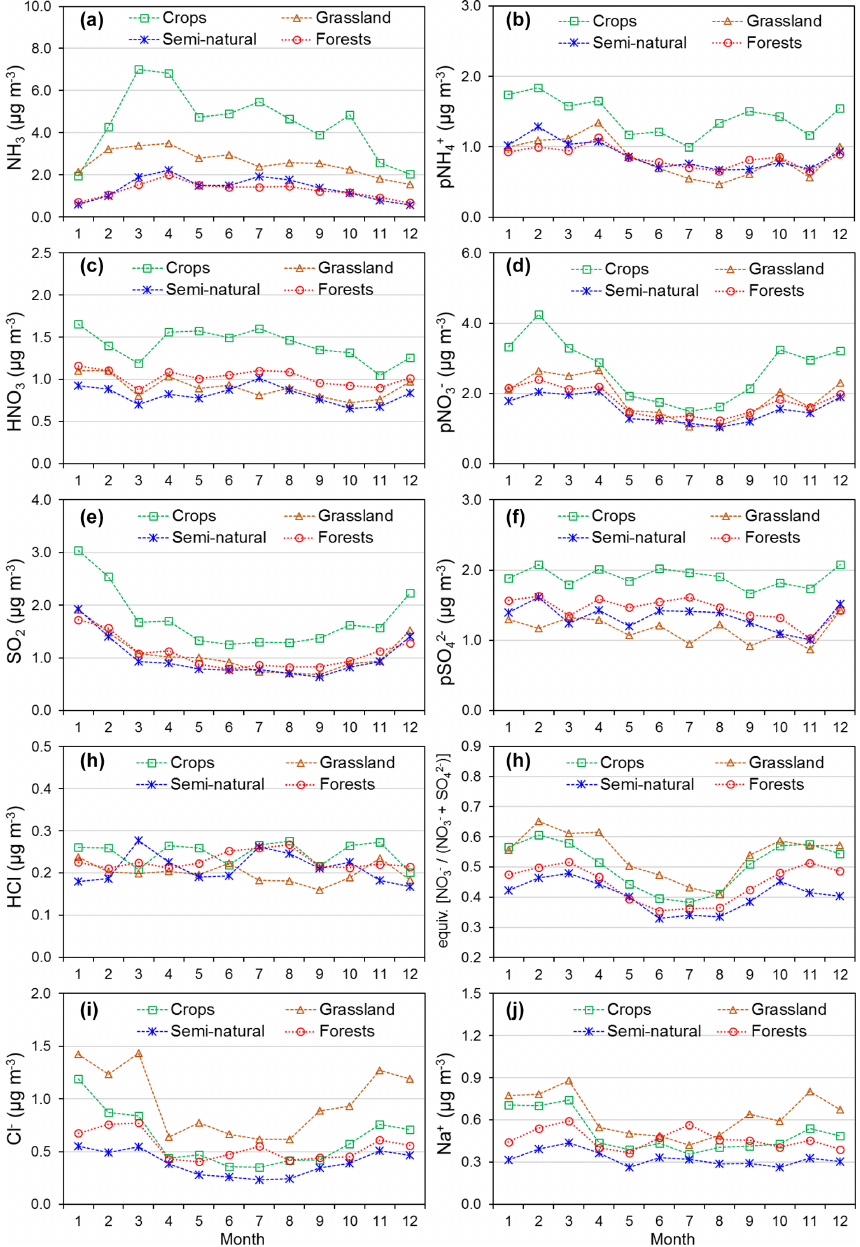
Figure 14. Seasonal variability in atmospheric gas (a) NH 3 , (c) HNO 3 , (e) SO 2 , (g) HCl) and aerosol concentrations (b) pNH + (f) pSO 2 − , (i) pCl − , (j) pNa + (p in front of component name denotes particulate). Each data point is the monthly averaged concentra- 4 tions of grouped sites for the period 2006 to 2010, classified according to four ecosystem types: crops ( n = 10), grassland ( n = 10), semi- natural ( n = 11), and forests ( n = 35). Graph (h) shows the monthly mean ratio of molar-equivalent (equiv.) concentrations of NO − + SO 2 (NO − ). Month 1: January; Month 12: 3 4